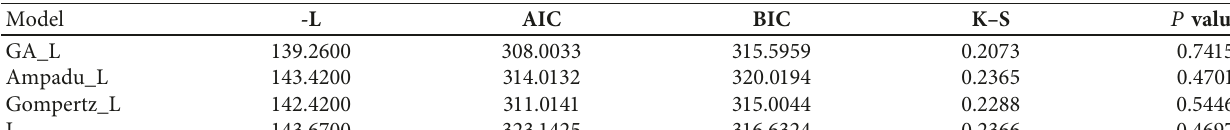
Table 4: Goodness-of-fit for dataset survival times.